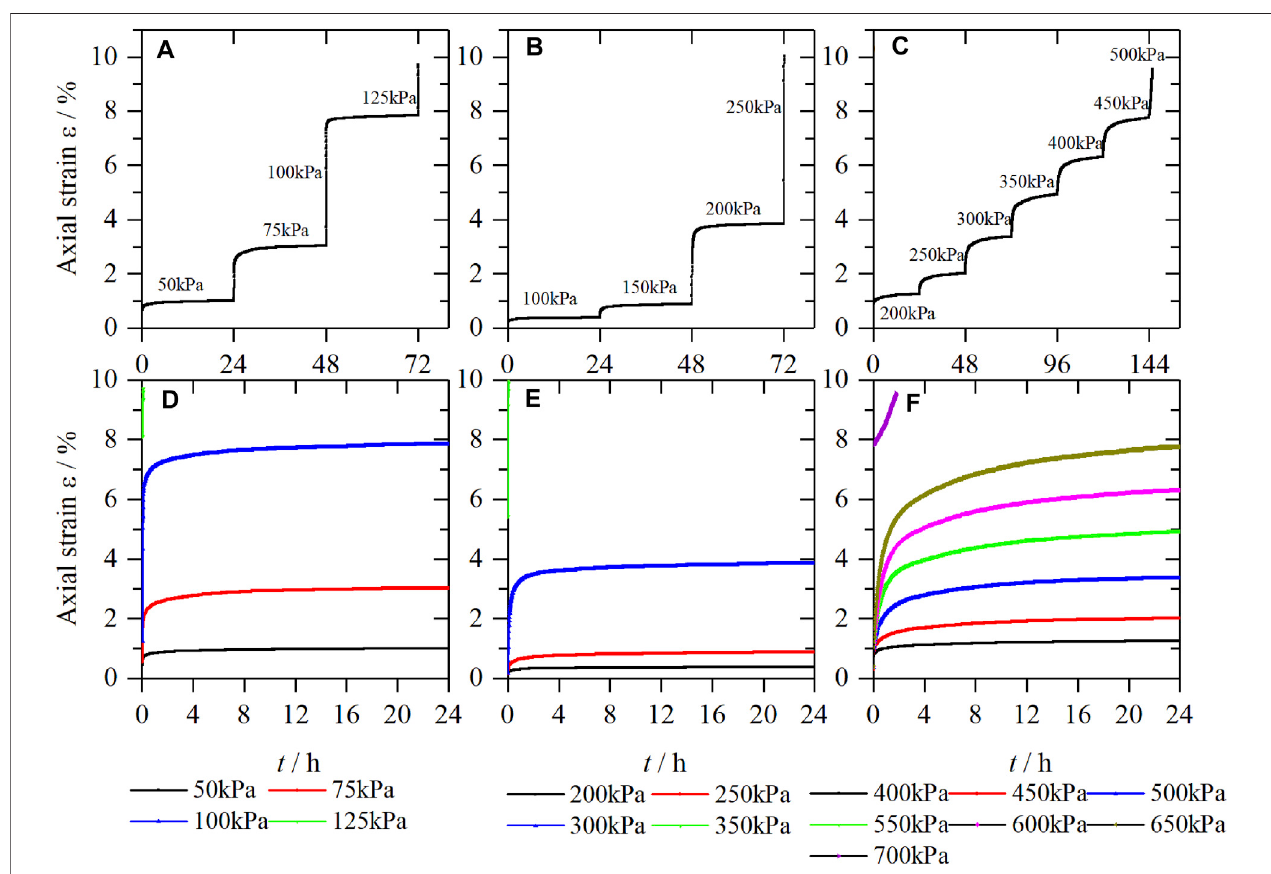
FIGURE 7 | Strain-time curves of samples, (A) LC-1 (B) LC-2, (C) LC-3, and creep curves of samples, (D) LC-1, (E) LC-2, (F) LC-3.